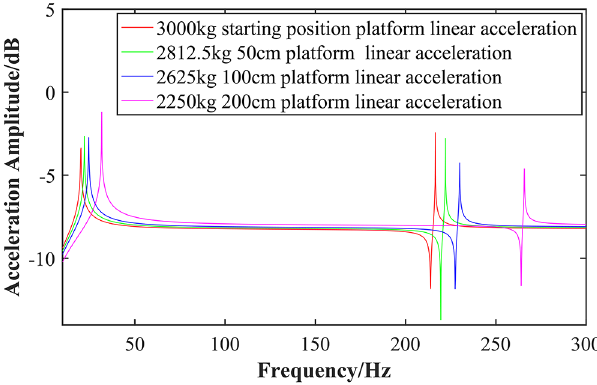
Fig. 7. Frequency responses of FDS vs position and